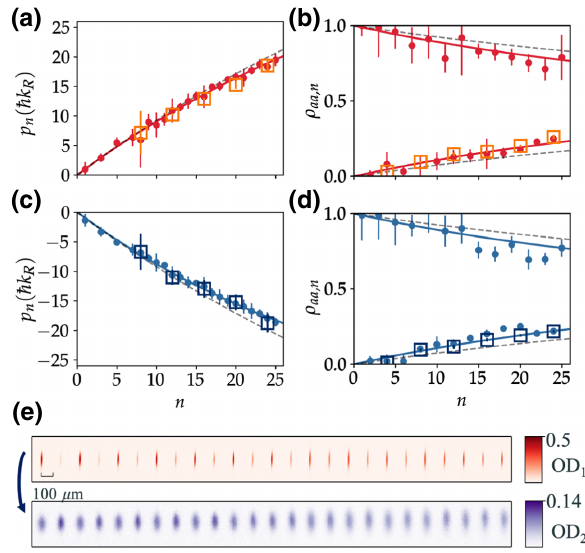
FIG. 4. Measurements of recoil momentum and hyperfine pop- ulation transfer by multiple SDKs optimized at τ c = 40 ns. Normalized momentum transfer p n and hyperfine population ρ aa , n versus kick number n are plotted in (a),(b)(c),(d), respec- tively. The atoms are initialized in F = 2, | b m (cid:4) states. Results ( ± k ) SDK sequence, starting with ˜ U ( k ) ˜ U ( − k ) for the ˜ U ( n ) R u R u R uu and ˜ U u ( − k R ) ˜ U u ( k R ) , are plotted in top (a),(b) and bottom (c),(d) panels with disk symbols, respectively. Results for the bal- ( ± k ) [Eq. (11)] with N = 2 − 6 anced chirp-alternating ˜ U ( 4 N ) R uddu are plotted via open squares. For comparison, spontaneous- emission-limited p n and ρ aa , n according to numerical simulation are plotted with black dashed lines. A phenomenological fit (solid red and blue curves) suggests hyperfine Raman transfer effi- ciency f R = 98.8 ( 3 ) % for the experimental data. See discussions in the main text for inference of f SDK = 97.6 ( 3 ) % from the data. (e) Top: state-selective absorption images of atomic sample in F = 3, {| a m (cid:4)} states, probed immediately after n = 1 − 25 SDK ˜ U ( n ) ( k ) pulses. Bottom: corresponding absorption images of R uu optically repumped atomic samples with τ TOF = 160 μ s. Notice the n -odd measurements with higher OD 1 suffer stronger probe- induced heating and thus wider OD 2 distributions probed later, as